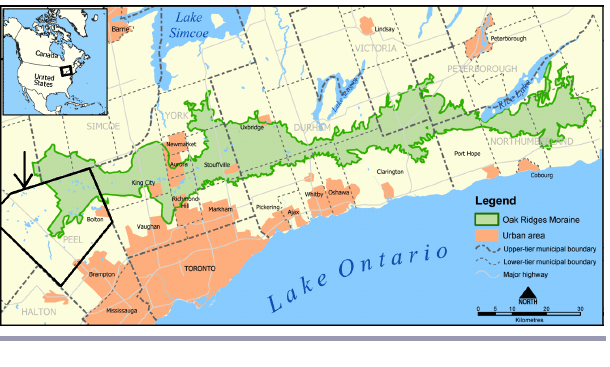
Fig. 1. Location of Caledon, marked by bold black lines, relative to other municipalities on the Oak Ridges